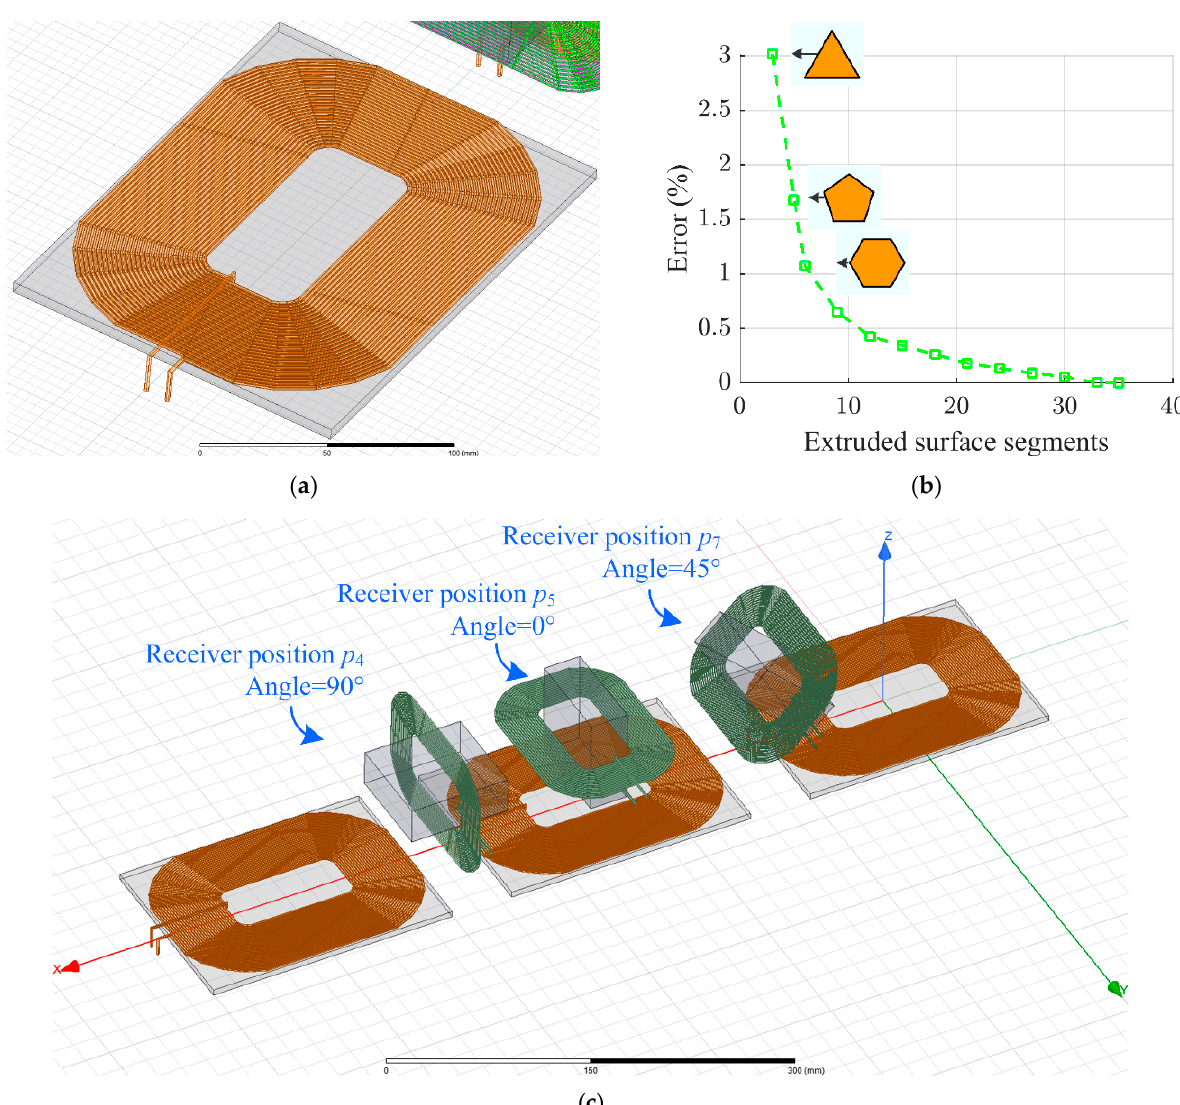
Figure 6. Simulation model for the FEM analysis: ( a ) transmitter coils ( L 1 , L 2 , L 3 ) design, ( b ) simulation error of the coil parameters for different extruded surface segments and ( c ) different positions of the receiver along the track. Table 2. FEM and electrical model